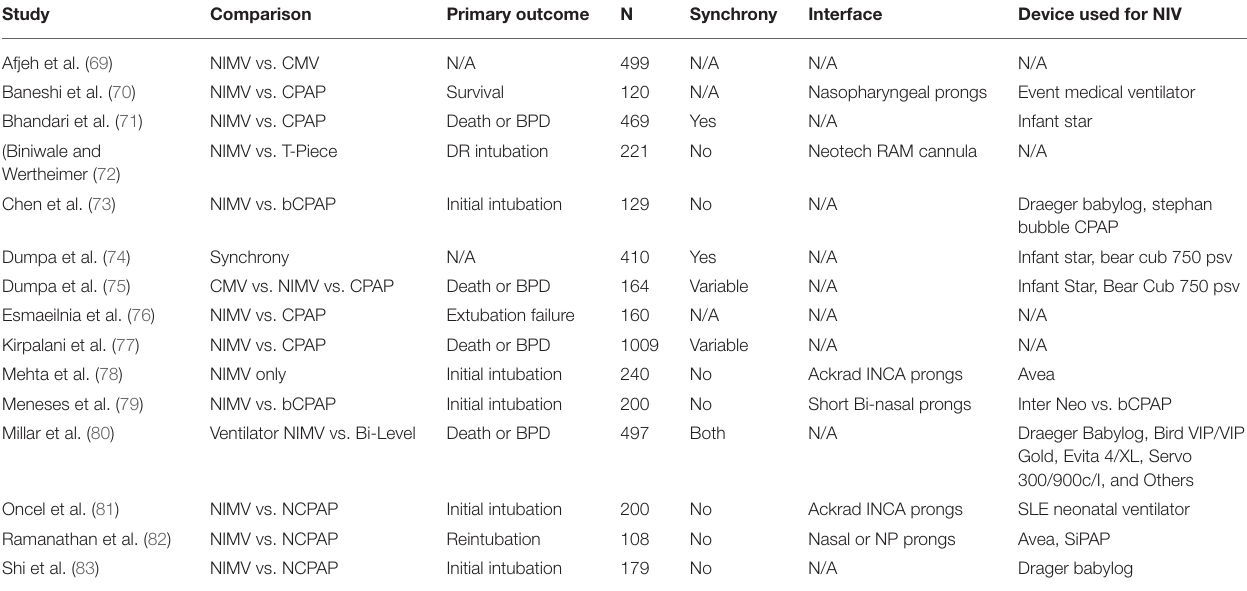
TABLE 1 | The Larger NIMV studies, their comparisons, and the different interfaces and ventilators utilized.